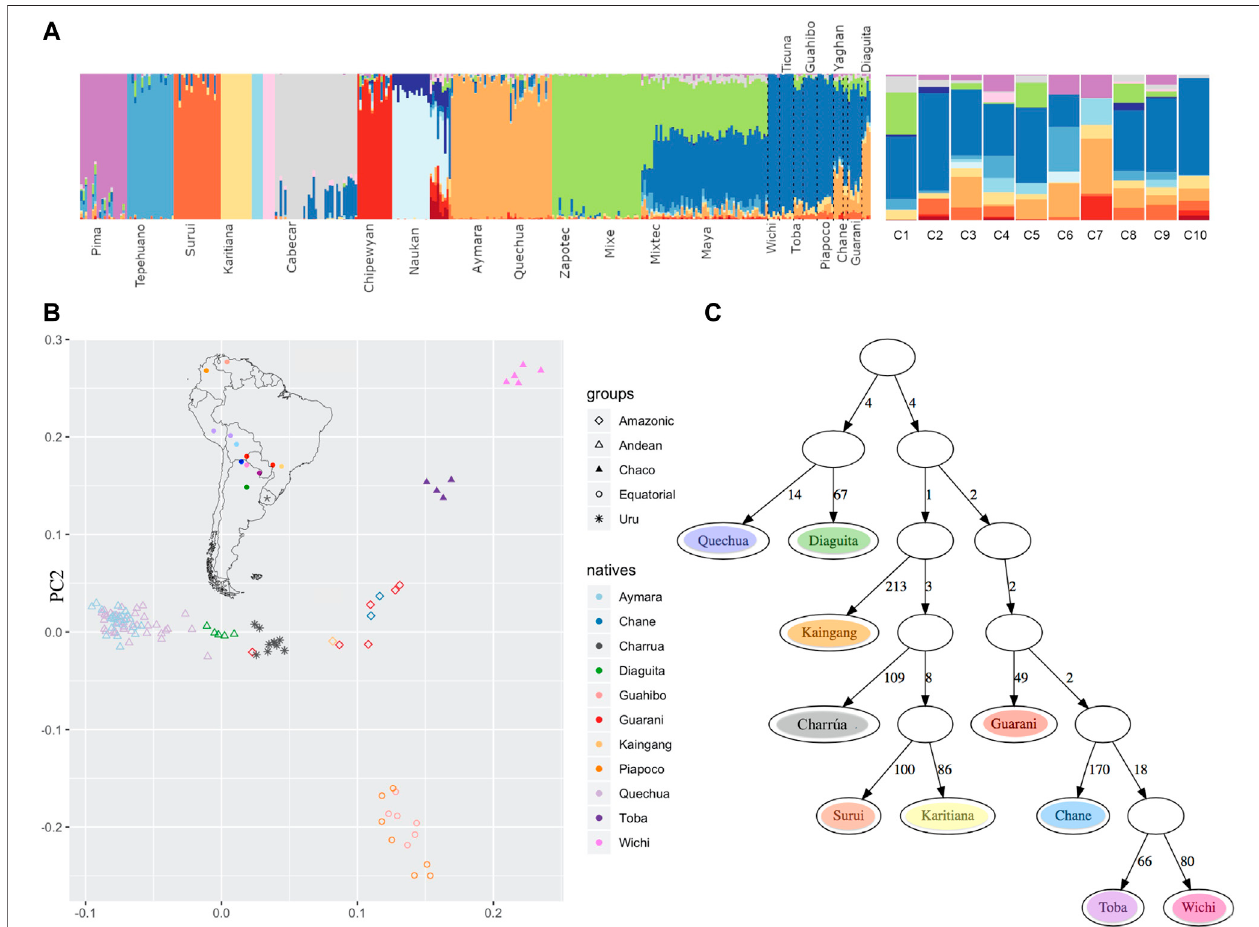
FIGURE 5 | Comparison with other indigenous groups (A) Admixture at fi ne scales (with K (cid:1) 19). After running ADMIXTURE for K (cid:1) 19, the European and African clusters were discarded, and only indigenous contributions were considered. To the left, the reference Amerindian panel is shown and to the right the 10 Uruguayan indigenous descendants, where a high proportion of blue is observed in most of them. (B) PCA admix on masked chip data (C) qpgraph on masked chip data. The number on each edge represent genetic distance units scaled by a factor of 1000. The F4 statistic corresponding to this topology is: Surui Kairitiana Wichi